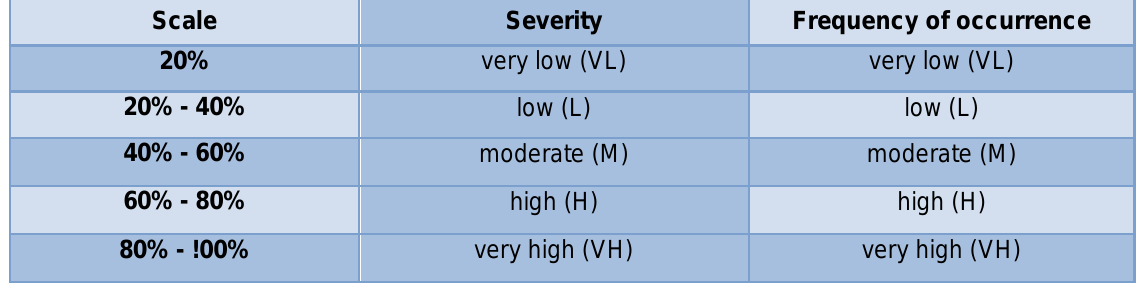
Table 1 Scale used to identify factor's severity and frequency of occurrence The average value for responses to each factor is calculated to find out its severity degree and frequency of occurrence. Then, the risk map for factors affecting time overrun in road construction projects in the West Bank was developed based on Figure 1. The map is a 5x5 matrix with severity ranging from VL to VH on the horizontal axis and frequency (with the same range) on the vertical axis (The U.S. Federal Highway Administration Office of International Programs, 2007).